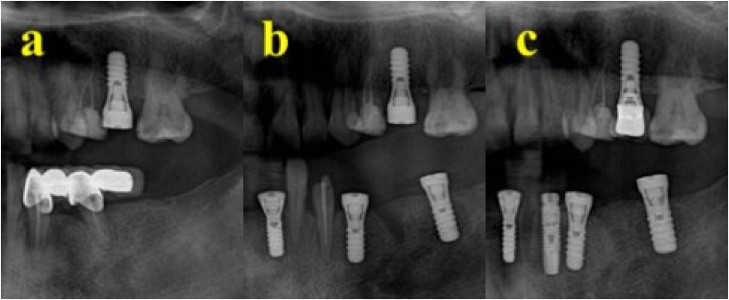
Case one showing (A) inserted upper implant, (B) inserted lower implants, (C) loading of the upper implant 12 months after insertion.